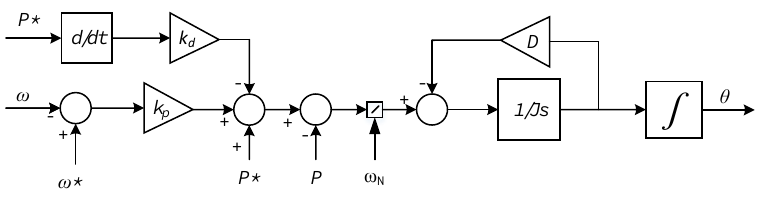
Figure 6. Control scheme of VSG controller.